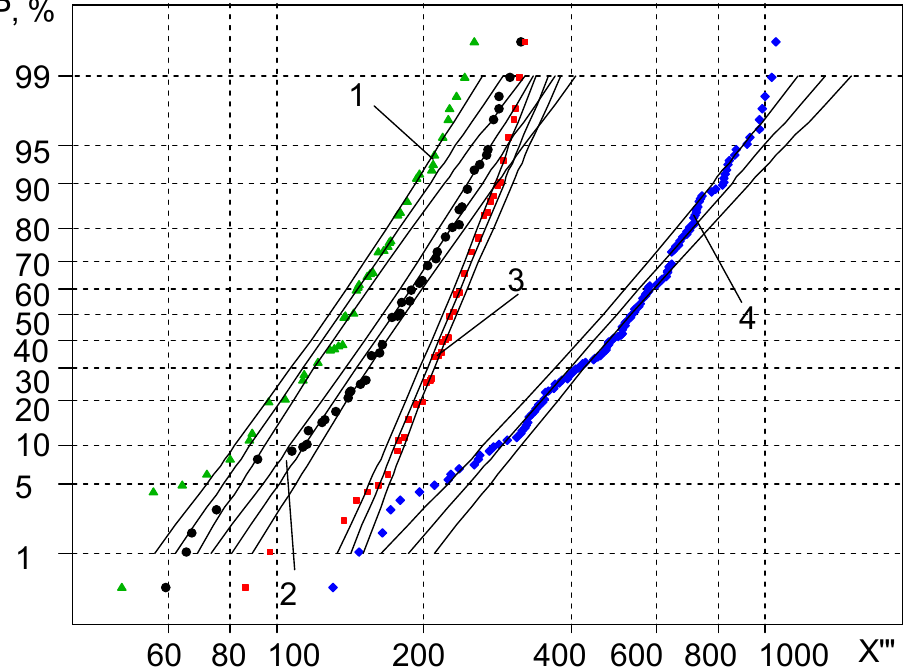
Figure 5. Statistical distribution curves for the mechanical properties of steel 15Cr2MoVA with identified sensitivity thresholds N 0 and N k (1— σ y , 2— σ pr , 3— σ u , 4— S k